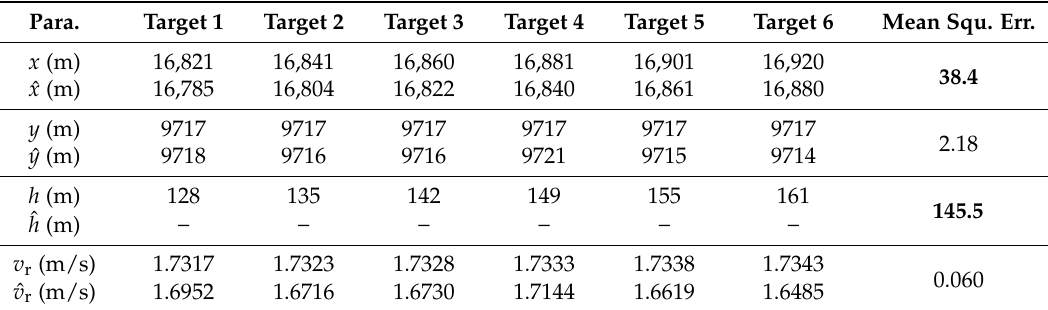
Figure 8. GMTI results of three-channel airborne Ro-XTI-SAR system. ( a ) is the previous SAR image; ( b ) is the image after DPCA of a traditional XTI-SAR with the baseline angle 90°; ( c ) is the image after DPCA of the proposed Ro-XTI-SAR system; ( d ) is the detection and relocation results of the moving targets.